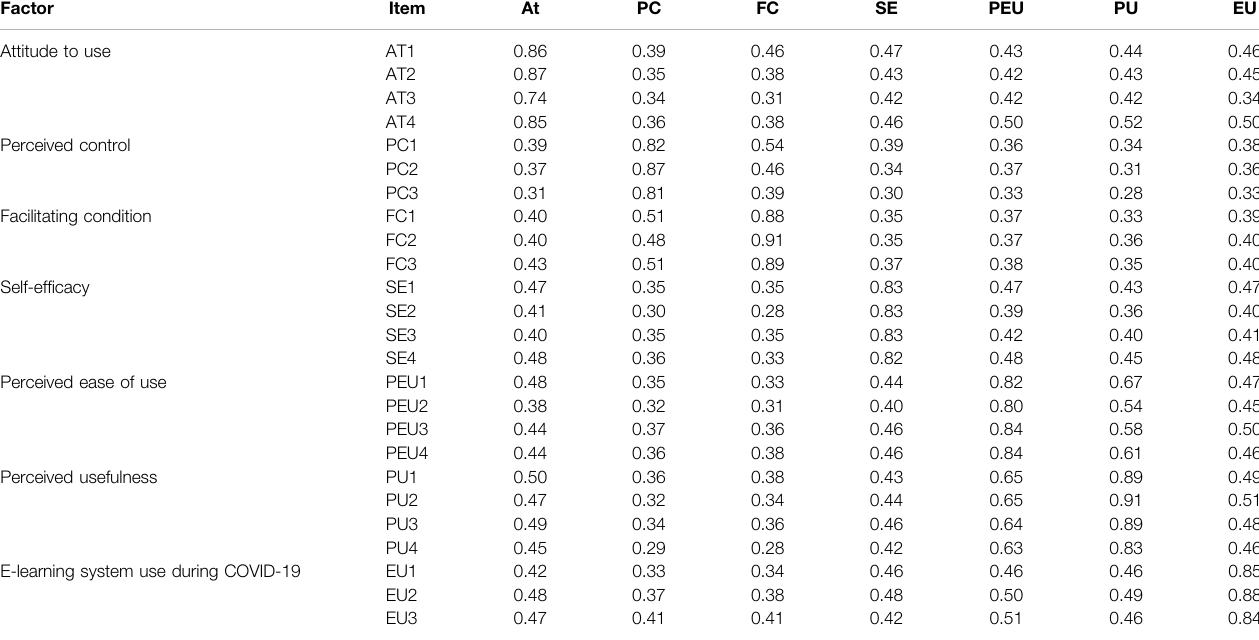
TABLE 1 | Factor analysis and cross-loading values.